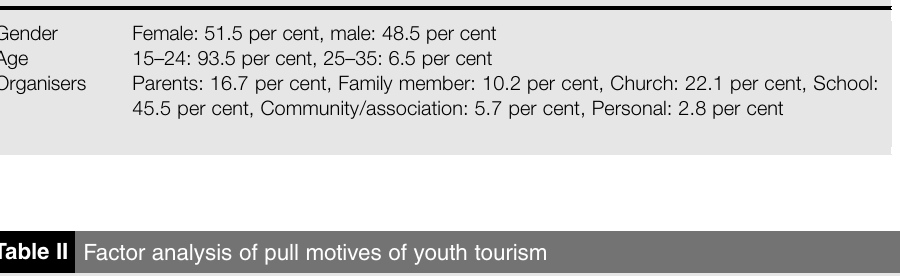
Table I Demographic characteristics and destinations visited by the participants Characteristics Distribution of answers Gender